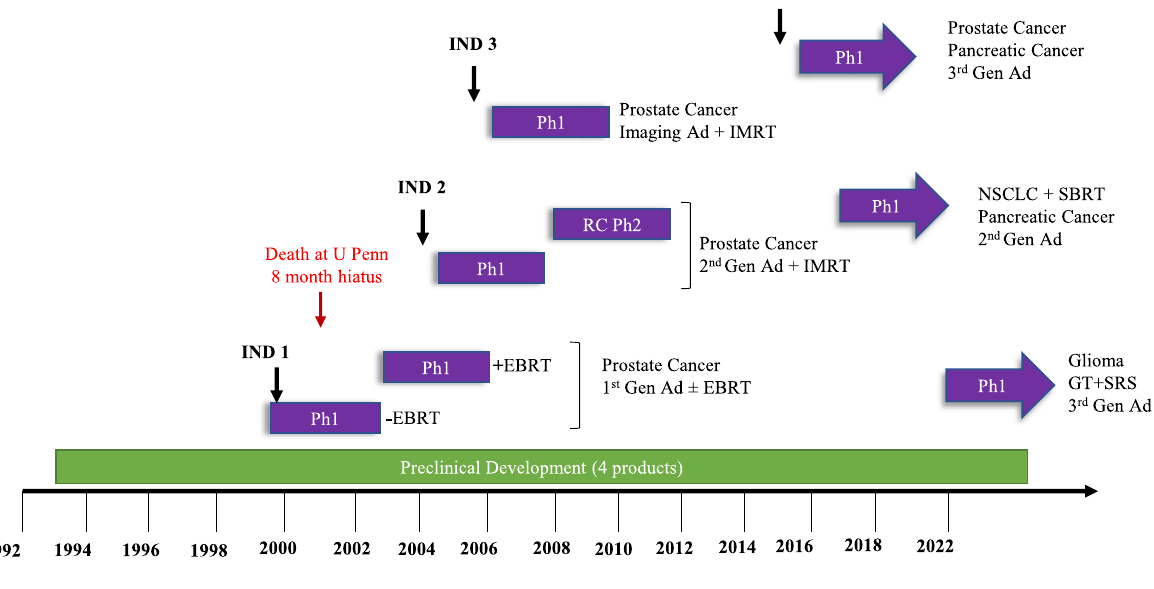
Fig. 2 Timeline of Gene therapy vector development and initiation of investigator initiated clinical trials at